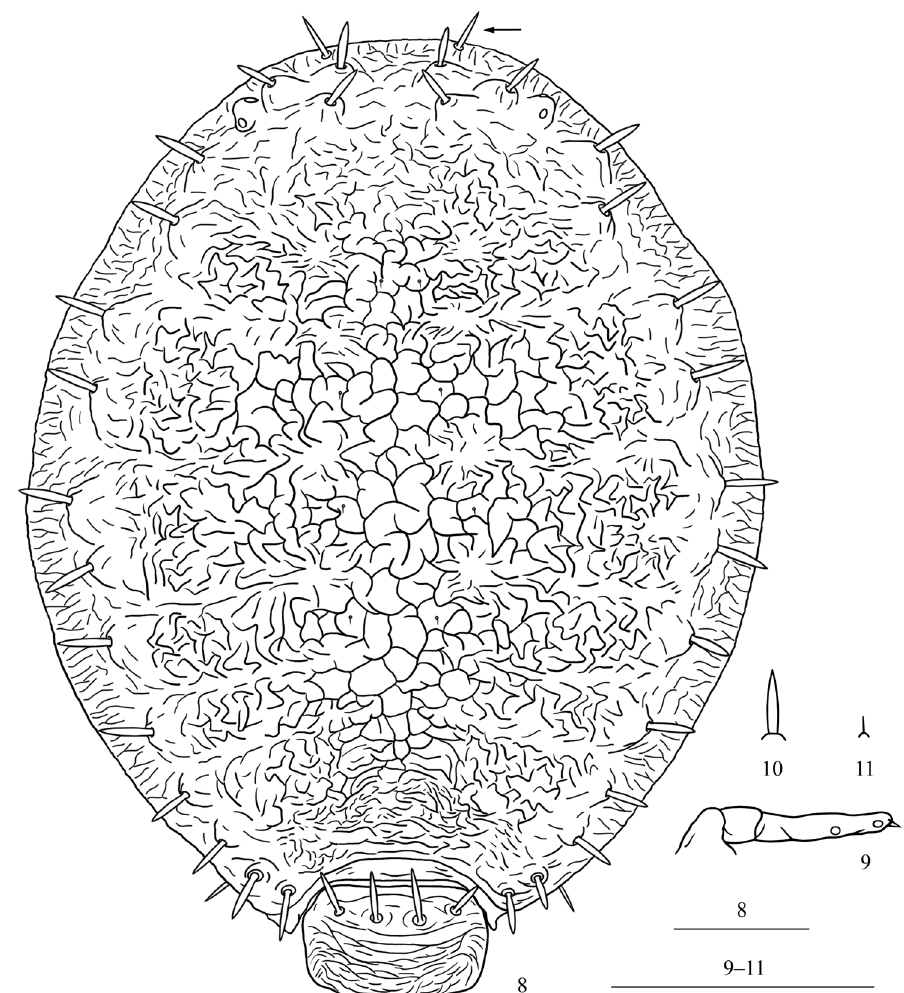
Figures 8–11. 8–9 Parathoracaphis spinapilosa sp. n. Apterous viviparous female: 8 dorsal view of body 9 antenna 10–11 Frontal seta: 10 P. spinapilosa sp. n. 11 P. setigera . Scale bars: 0.10 mm. and abdominal tergite I each with a pair of minute spinal setae. Abdominal tergite VIII with four setae, similar to submarginal setae on dorsal prosoma (Fig. 8). Frons not pro- tuberant. Eyes 3-faceted. Antennae 3-segmented, rarely 4-segmented, concealed under head, with two apical setae (Figs 9, 19). Primary rhinaria small, rounded, and placed wide apart. Rostrum short, reaching to fore coxae. Ultimate rostral segment short, thick, and blunt, with two pairs of primary setae and a pair of secondary setae (Fig. 20). Legs short, smooth, concealed under body, trochanter and femur fused. Tarsi 2-segmented. First tarsal chaetotaxy: 2, 2, 2. Dorsoapical setae on second tarsal seg- ment expanded at apex and longer than claws. Claws normal. Siphunculi absent.